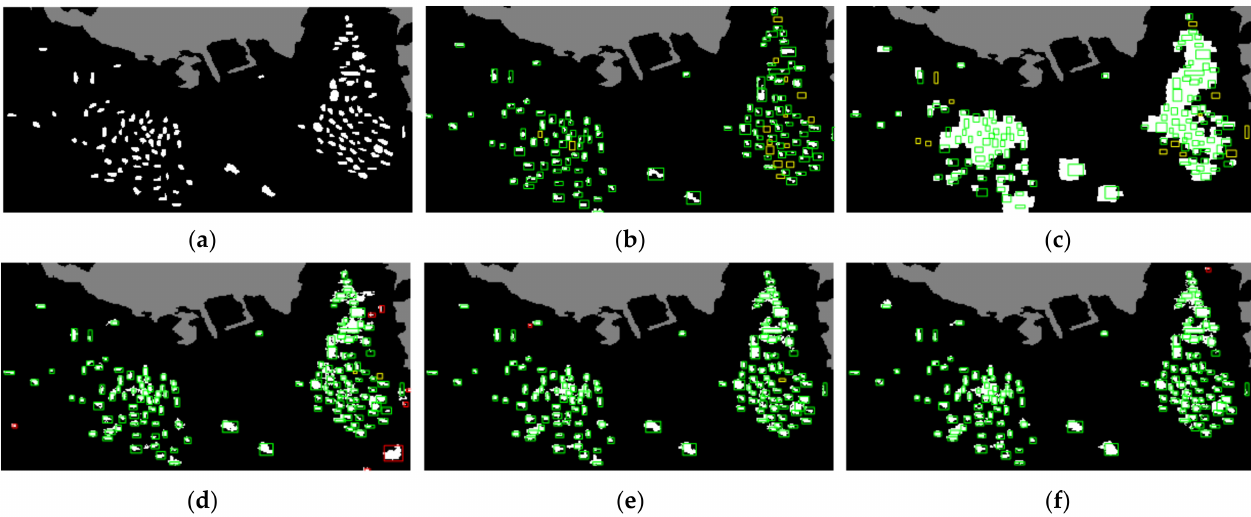
Figure 8. Detection results from Radarsat-2 area I. ( a ) Ground-truth image. ( b ) SO-CFAR. ( c ) SP. ( d ) T3 + SVM. ( e ) PCP + SVM. ( f ) Proposed method. (Green: correct detection, yellow: missed detection, red: false